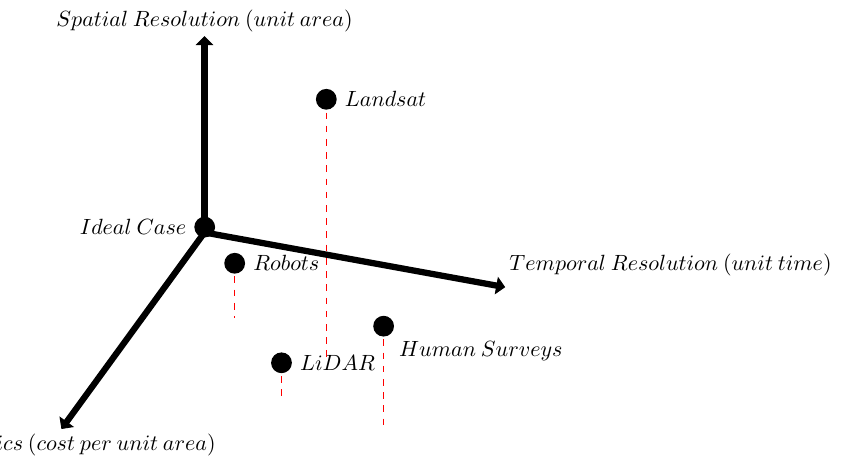
Figure 11. A comparison of small robots (UAVs and USVs) against LiDAR, human surveys, Landsat imagery, and the ideal case over three domains: (i) spatial resolution of data; (ii) temporal resolution of collection; and (iii) cost per unit area. The ideal case represents the highest temporal and spatial resolution at no cost. LiDAR data has high spatial resolution, but collection is expensive and infrequent. Landsat imagery, typically captured bi-monthly, has 15–30 m spatial resolution. While inefficient, spatial resolution of human surveys increases with additional time and